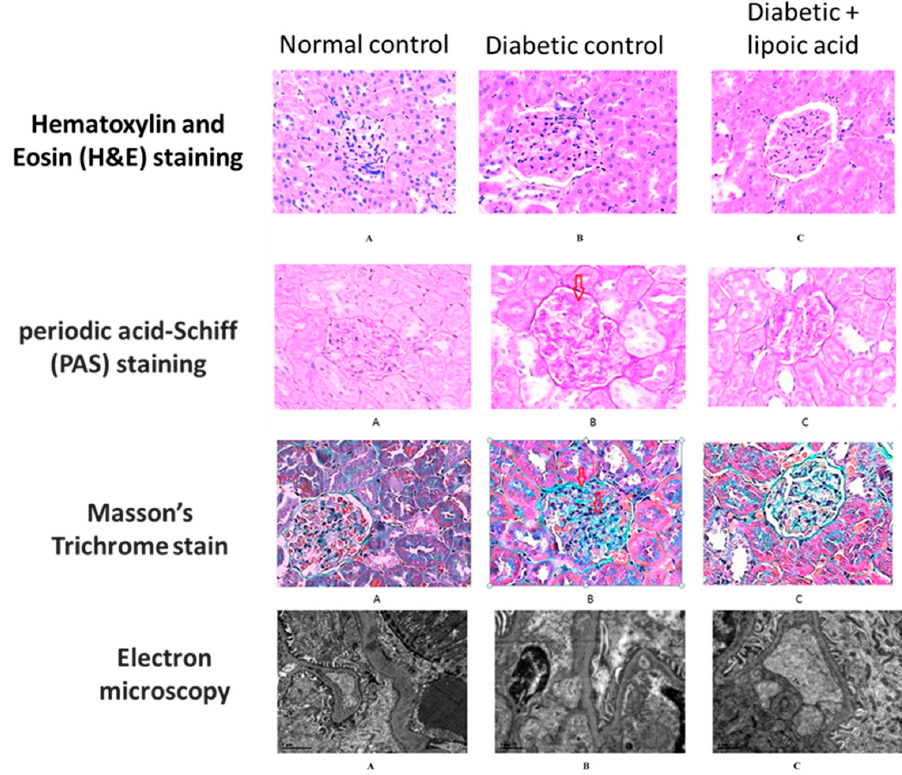
Figure 5. Protective e ff ects of lipoic acid on diabetic kidney disease. Histological staining of the kid- ney tissues derived from control, diabetic, and diabetic + lipoic acid treatment. This fi gure was re- produced from reference [55]. For all the microscopic images, the ampli fi cation magnitude is ×800. ( A ) normal control group; ( B ) diabetic control group; ( C ) diabetic + ALA group. Glomerular hyper-